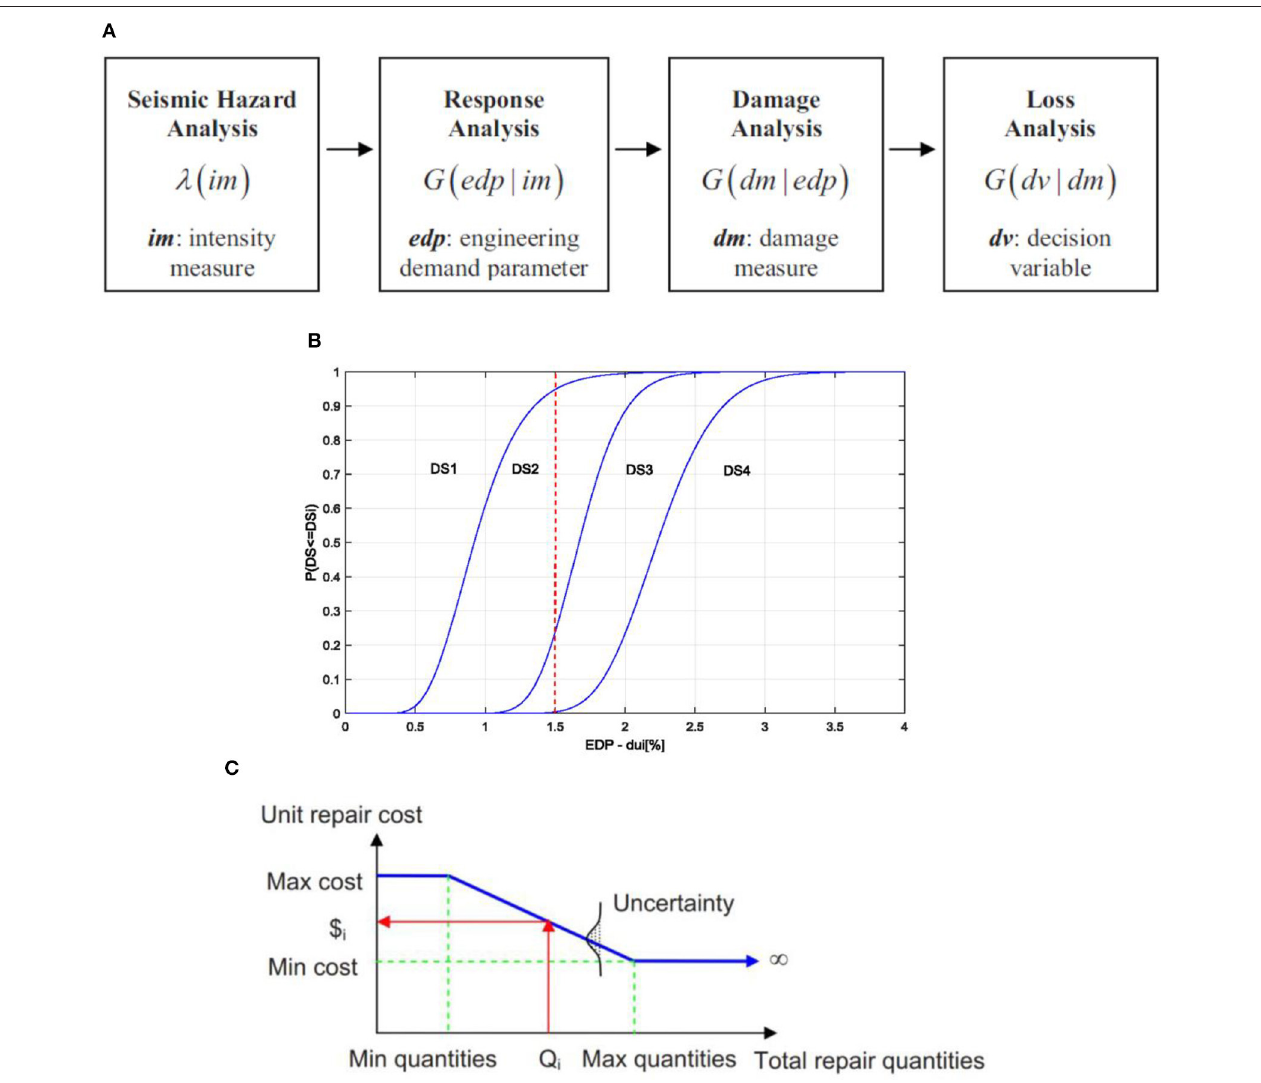
FIGURE 7 | (A) Performance-assessment framework (Moehle and Deierlein, 2004). (B) Fragility curves for MD-CBFs. (C) Example of the unit repair cost function ( Yang et al.,